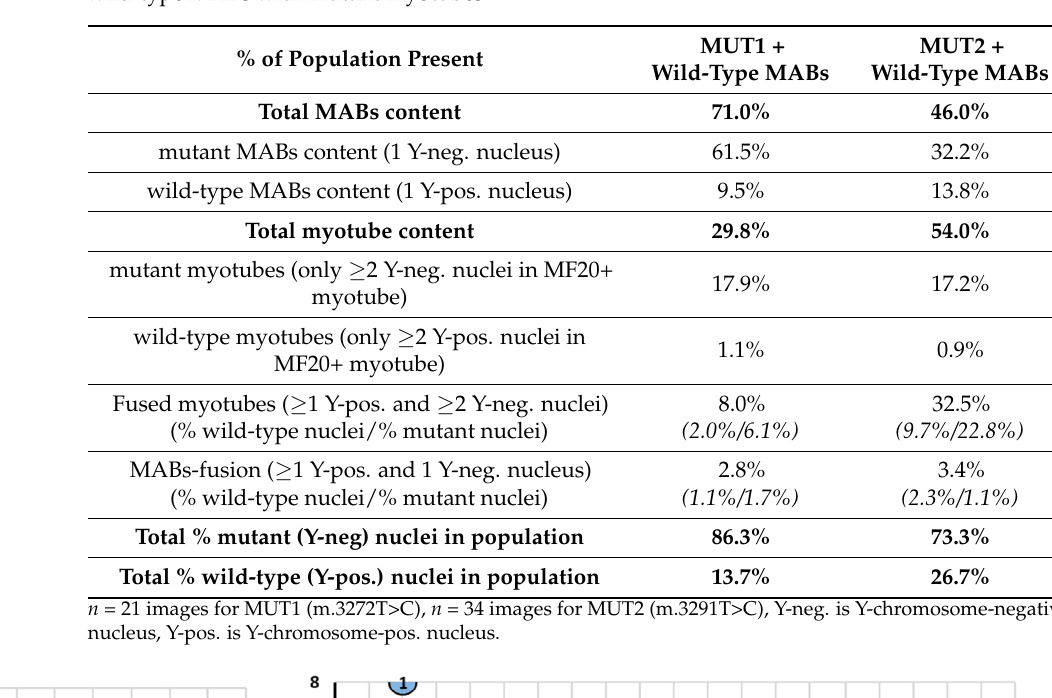
Table 1. Distribution of nuclei in subpopulations at myogenic differentiation day 11 after mixing wild-type MABs with mutant myotubes.